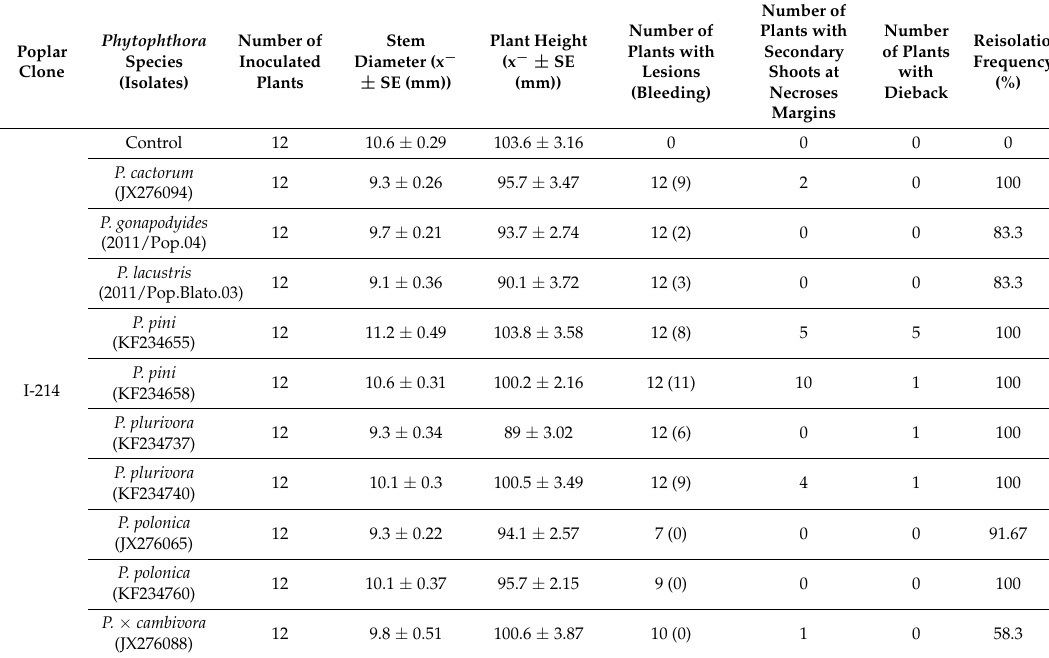
Table 3. Results of the underbark inoculation test with Populus × euramericana clones I-214 and P á nnonia and seven Phytophthora spp. after 11